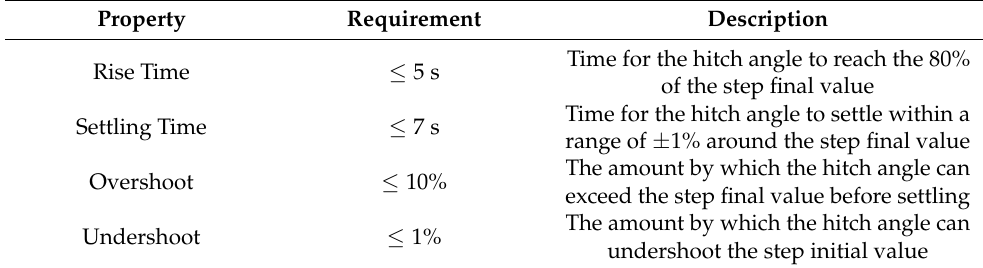
Table 2. Desired ATV step response requirements.